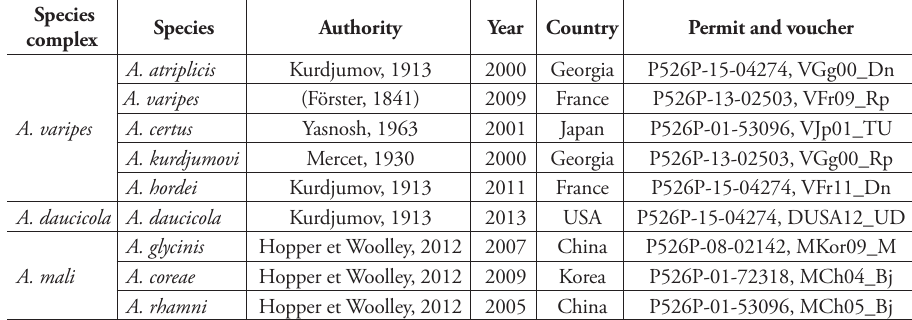
Table 1. The nine Aphelinus species studied, the year and country of their collection, permit and voucher numbers. Species